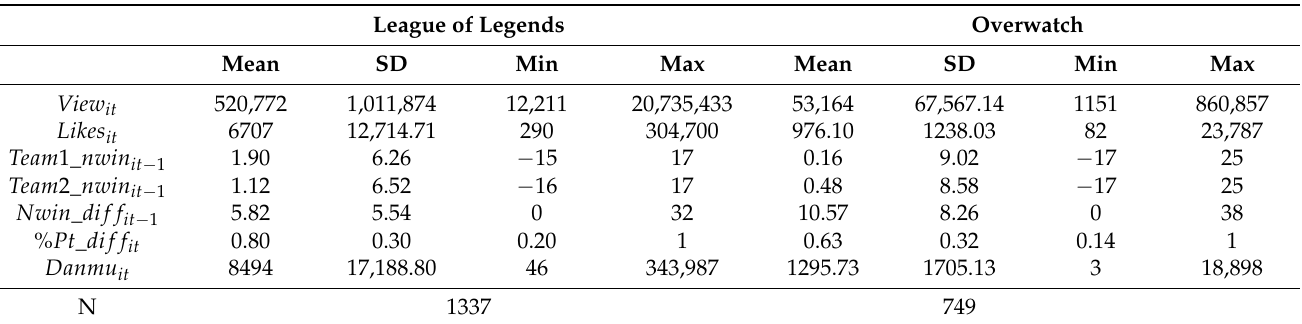
Table 2. Summary Statistics of Full Esports Matches.